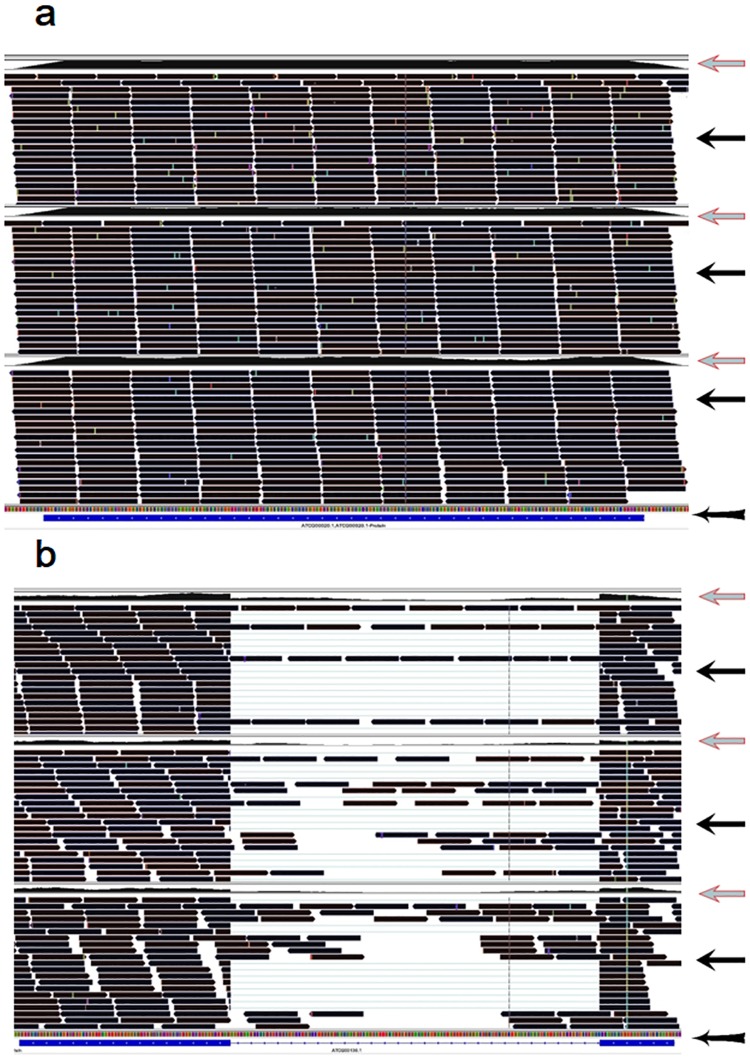
Screenshots from the IGV visualized program present two typical types of m6A topologies in the coding RNAs in the Arabidopsis chloroplast/amyloplast.Extent of m6A methylation, sequencing depth, sequencing fragment alignment, and gene ID of the sequencing data can be clearly visualized by the IGV program [42]. The area in the screenshot indicated by the arrow, “Red leftwards arrow”, presents m6A methylation extent across the transcript. The area in the screenshot indicated by the arrow, “Black leftwards arrow”, presents sequencing fragment alignment across the transcript. The area in the screenshot indicated by the arrow, “Black leftwards arrow with tail”, presents gene ID information including gene ID, sequence reading direction, the intron and exon regions. (a) Type 1 (representative gene, ‘ATCG00020’, expressed for ‘photosystem II reaction center protein A’), the whole transcript without intron was highly methylated by m6A; and (b) Type 2 (representative gene, ‘ATCG00130’, expressed for ‘ATPase, F0 complex, subunit B/B’), the exon was highly methylated but the intron was less methylated by m6A. Trace files of three organs, leaves (the upper), flowers (in the middle) and roots (the lower) were presented within a screenshot.